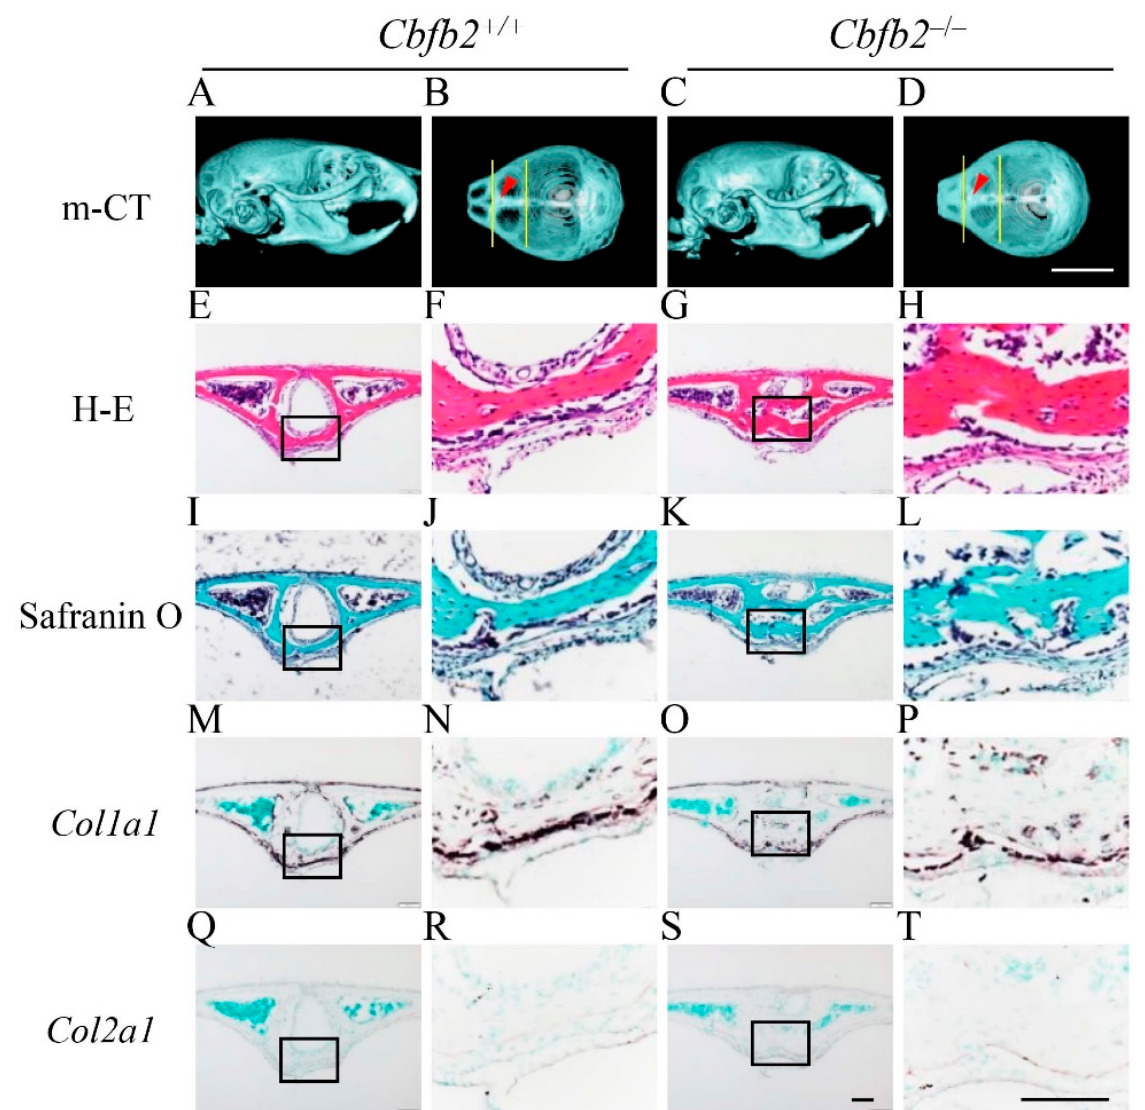
Figure 7. Micro ‐ CT and histological analyses of posterior frontal sutures in Cbfb2 +/+ and Cbfb2 –/– mice at P28. ( A – D ) Lateral ( A , C ) and dorsal ( B , D ) views of micro-CT images of skulls. The two lines in ( B , D ) show the anterior and posterior boundaries of the posterior frontal suture, and arrow heads indicate the location of coronal sections in the histological analyses. ( E – H ) H-E staining. ( I – L ) Safranin O staining. ( M – T ) In-situ hybridization using Col1a1 ( M – P ) and Col2a1 ( Q – T ) probes. The boxed regions in the left columns were magnified in the right columns. Scale bars: 0.5 cm ( A – D ) and 100 µ m ( E – T ). Three Cbfb2 +/+ and Cbfb2 − / − mice were analyzed.